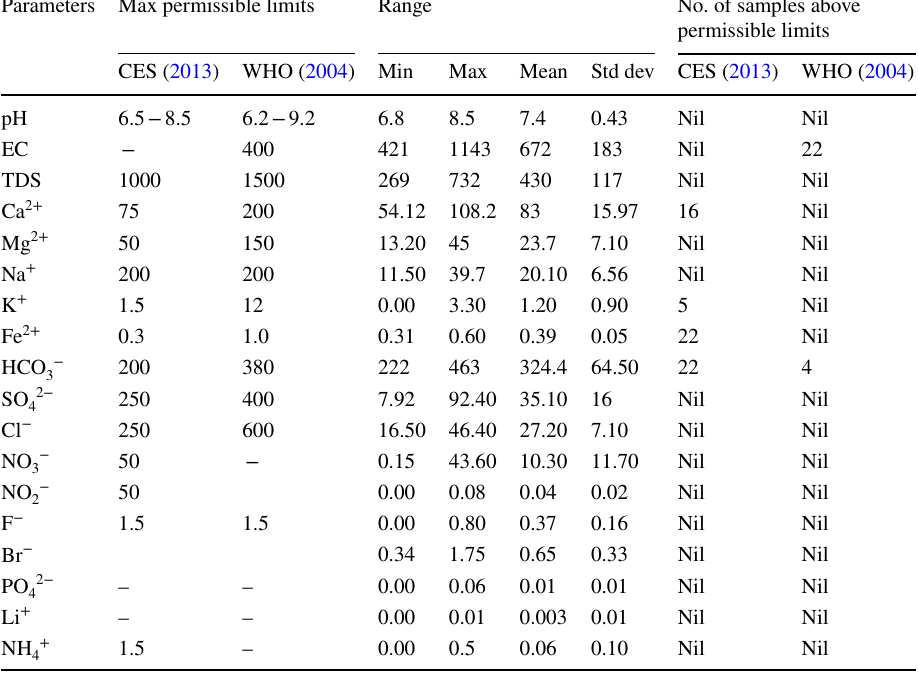
All units are in mg/L except for EC (µS/cm) and